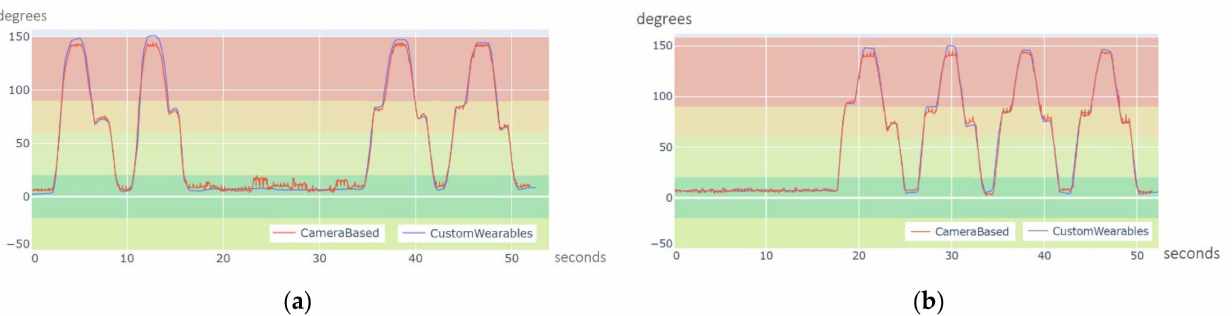
Figure 9. Estimated elbow joint angle for two flexion extension movements as a function of time: ( a ) Deep Stream right elbow (red) vs. CW right elbow (blue); ( b ) Deep Stream left elbow (red) vs. CW left elbow